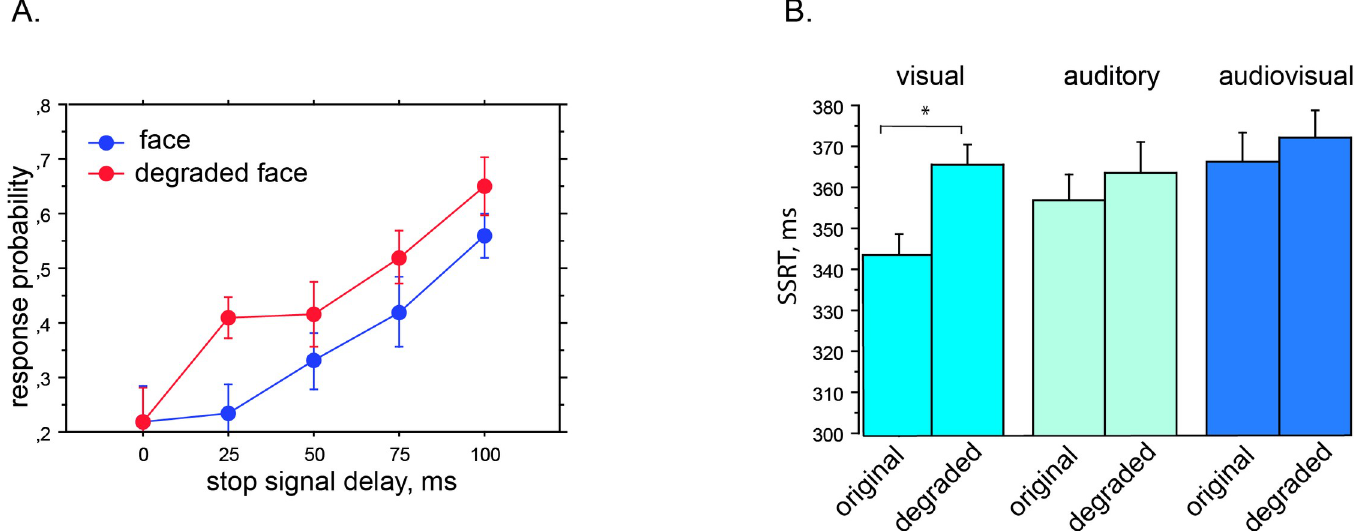
Fig 2. Effects of semantic load on response probability and stop–signal reaction time. Note . Panel A shows that response probability was lower for the original faces used as stop signals than for the degraded faces. This means that the original faces were more efficient in inhibiting action. Panel B indicates the effects of stop–signal modality and degradation on SSRTs. The effect of degradation on SSRTs was significant in the visual modality, as SSRTs were shorter for the original faces. � p < .05.